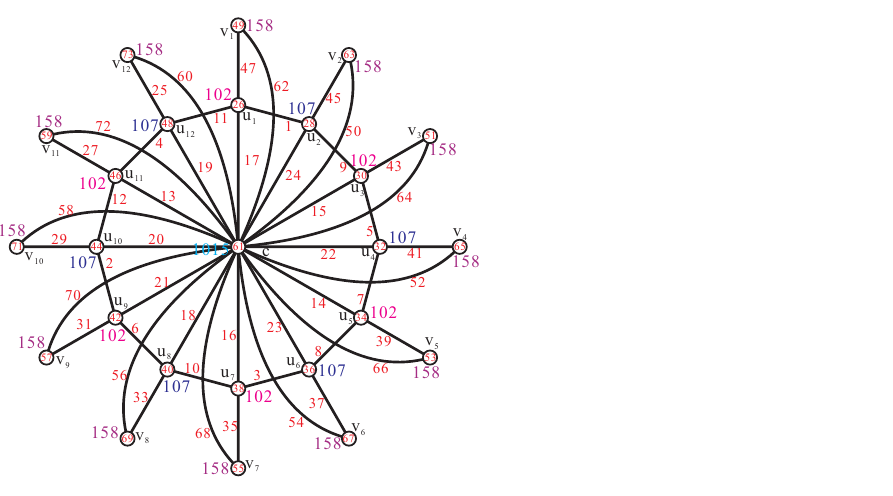
Figure 19. The local antimagic total labeling of F 12